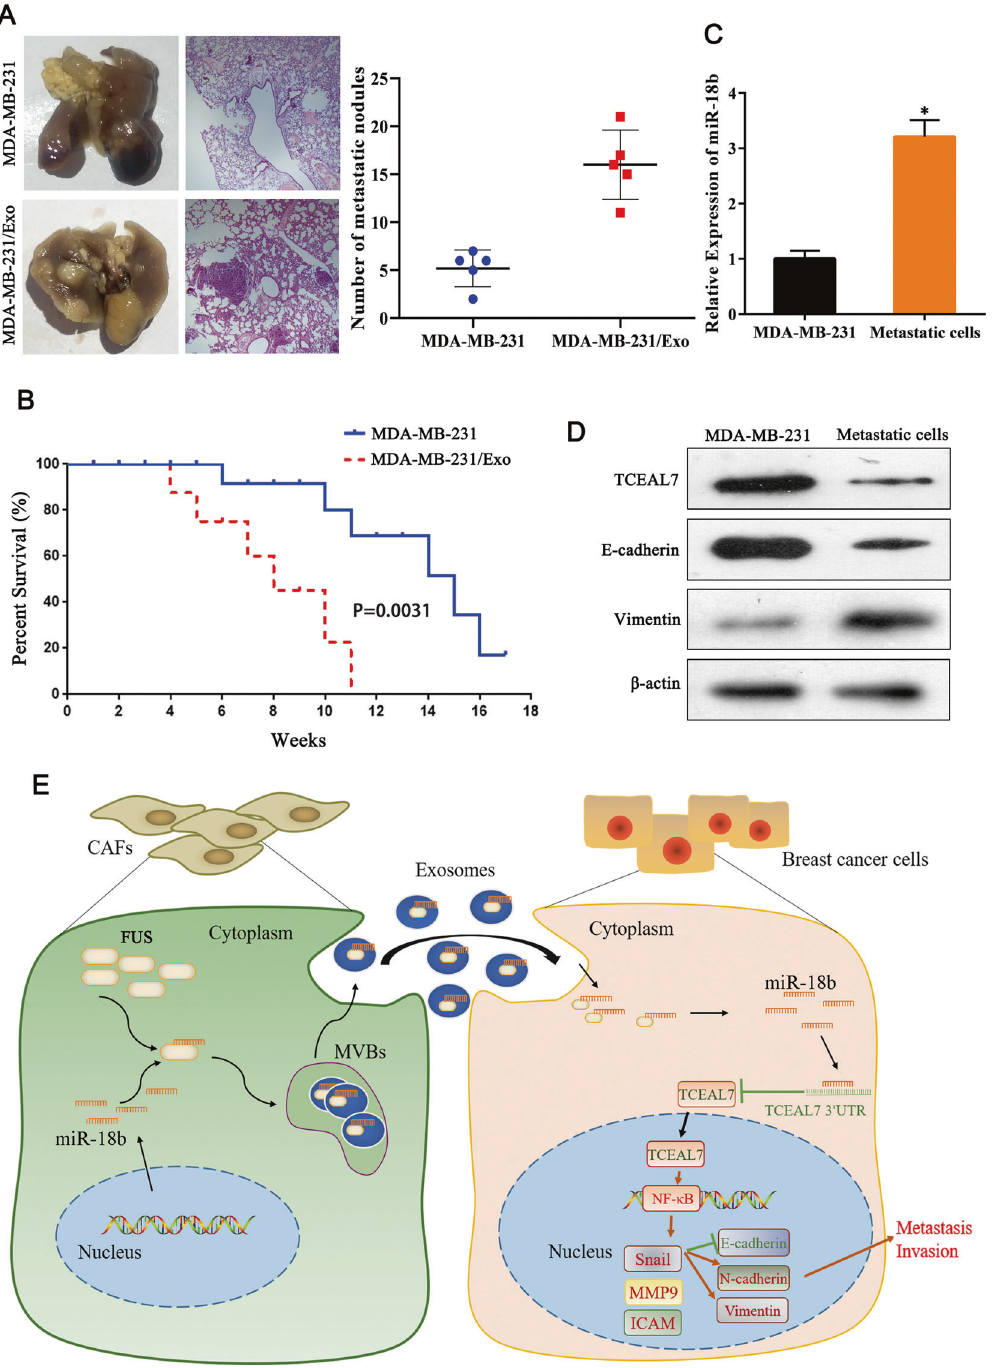
Fig. 7 Exosome miR-18b induces tumor growth and metastasis in mice. A Comparison of pulmonary metastases in mice ( n = 3). B Survival analysis showed that exosome miR-18b reduced survival rate in mice. C qRT-PCR detection of miR-18b expression in metastatic cells ( n = 3). D Western blot indicated the expression of TCEAL7, E-cadherin, and Vimentin in mouse lung metastatic cells ( n = 3). E A proposed model illustrating the role of CAF-derived exosomal miR-18b promotes BC cells invasion and metastasis by downregulation of TCEAL7. * indicates p < 0.05. The measurement data were expressed using mean ± SD, and the experiment was repeated three times. Comparisons between two groups are analyzed by and transferred from CAFs to cancer cells. miR-500a-5p promotes Exosomes from different cell sources are extracellular vesicles proliferation and metastasis of breast cancer cells by binding to enclosed by lipid bilayers that carry molecules such as miRNAs and ubiquitin-speci fi c peptidase 28 (USP28) [42]. Exosomal miR-92 derived proteins, which play an essential role in the communication between from cancer-associated fi broblasts promotes migration and prolifera- the tumor microenvironment and cancer cells. Chen et al. found that tion of breast cancer cells, miR-92 can promote PD-L1 expression by miR-500a-5p was upregulated in CAF and CAFs-derived exosomes